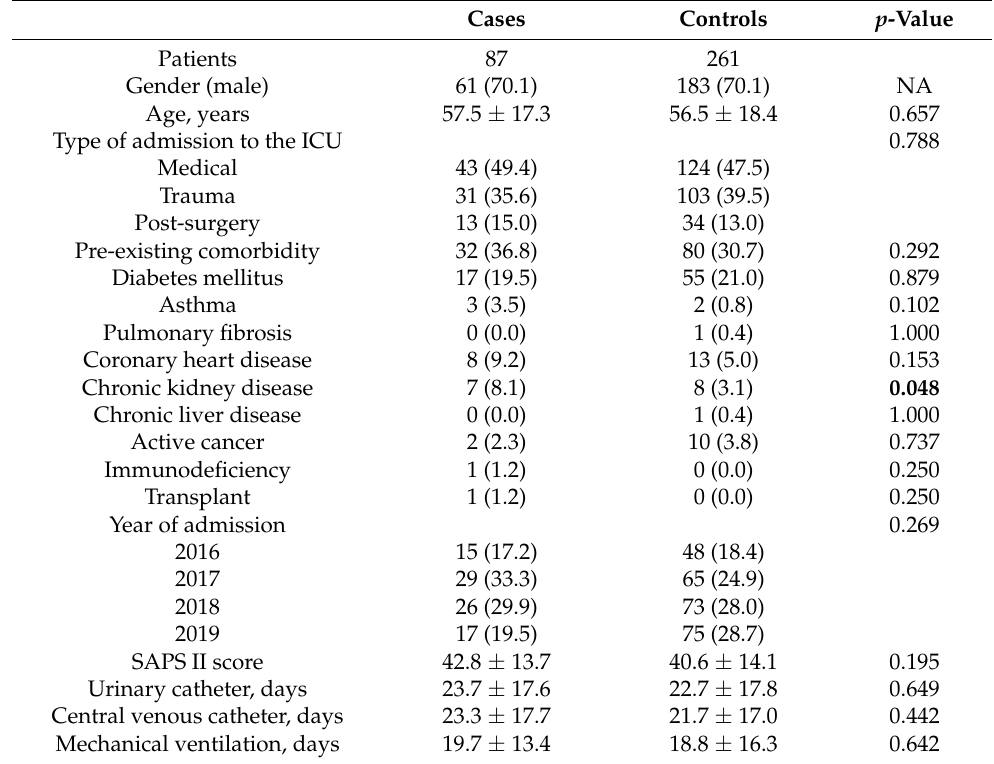
Table 1. Characteristics of the patients included in the nested case–control study. Results are expressed as number (percentage) or mean ± standard